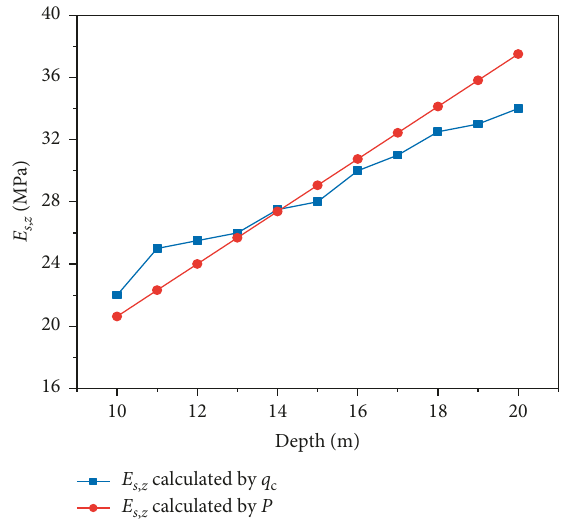
Figure 15: Settlement values for different empirical coefficients